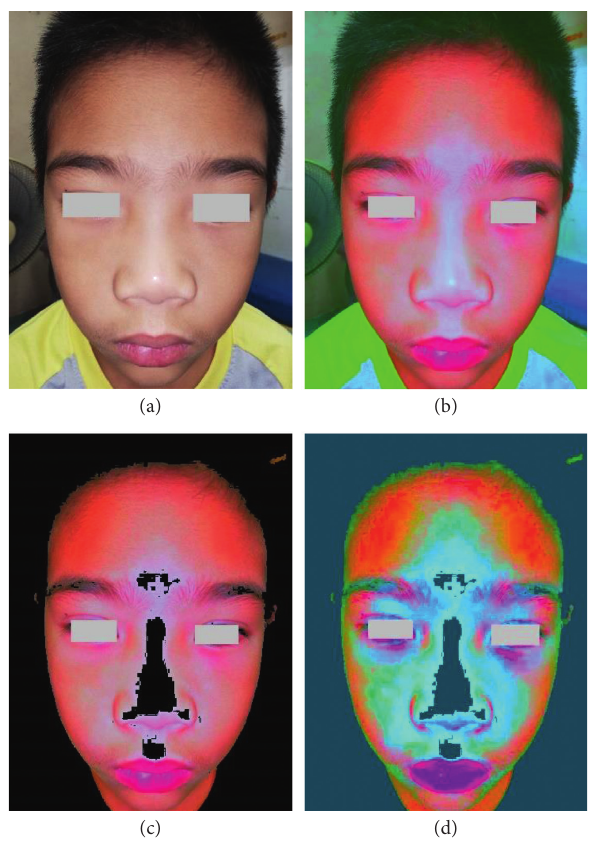
Figure 2: Four steps of the Manote and Matinun (M&M) technique for the 2 nd patient. (a) The original photograph by the smartphone camera app showed invisible facial flushing seen by the naked eye. (b) The 1 st decorrelation stretching picture using the YUV color space. (c) The K-means clustering picture choosing the red cluster. (d) The 2 nd decorrelation stretching picture using the Lab color